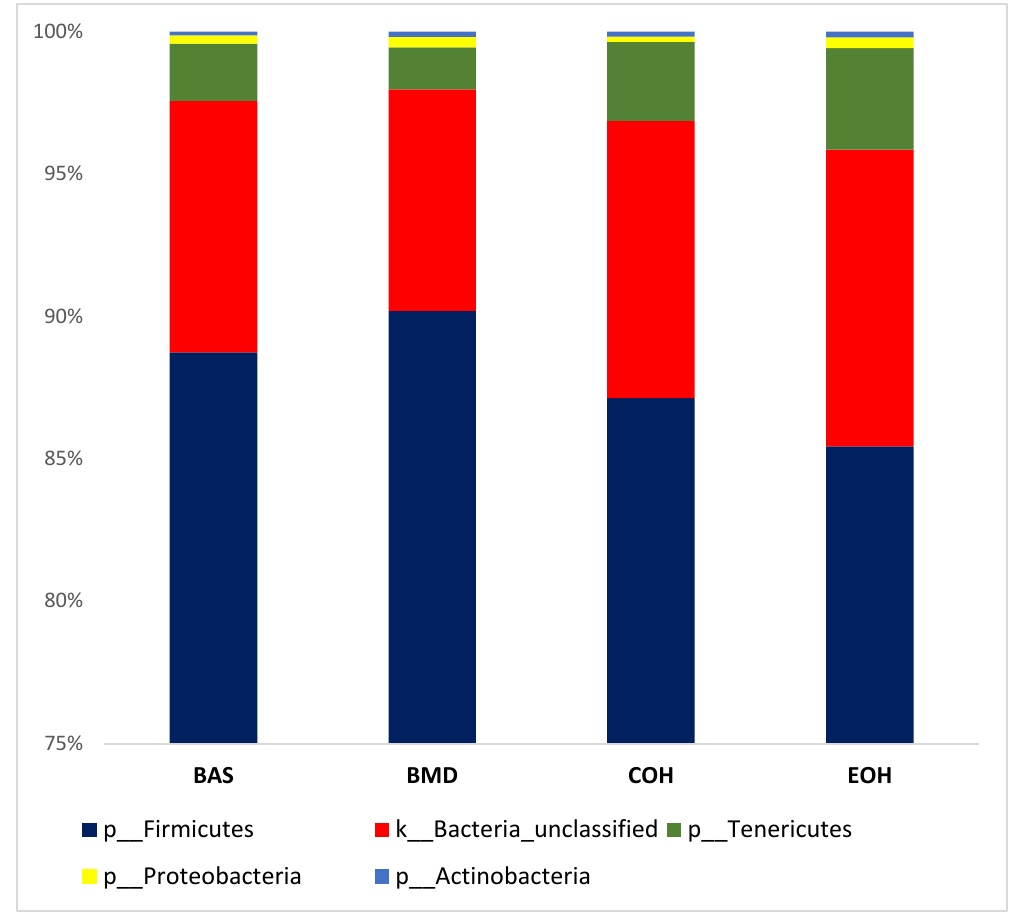
Figure 4. Illustration of the mean and standard error of the relative abundances of the most abundant Phyla. BAS = basal diet; BMD = antibiotic diet; COH = diet supplemented with 3% coarse oat hulls; and EOH = diet supplemented with 3% extruded oat hulls.